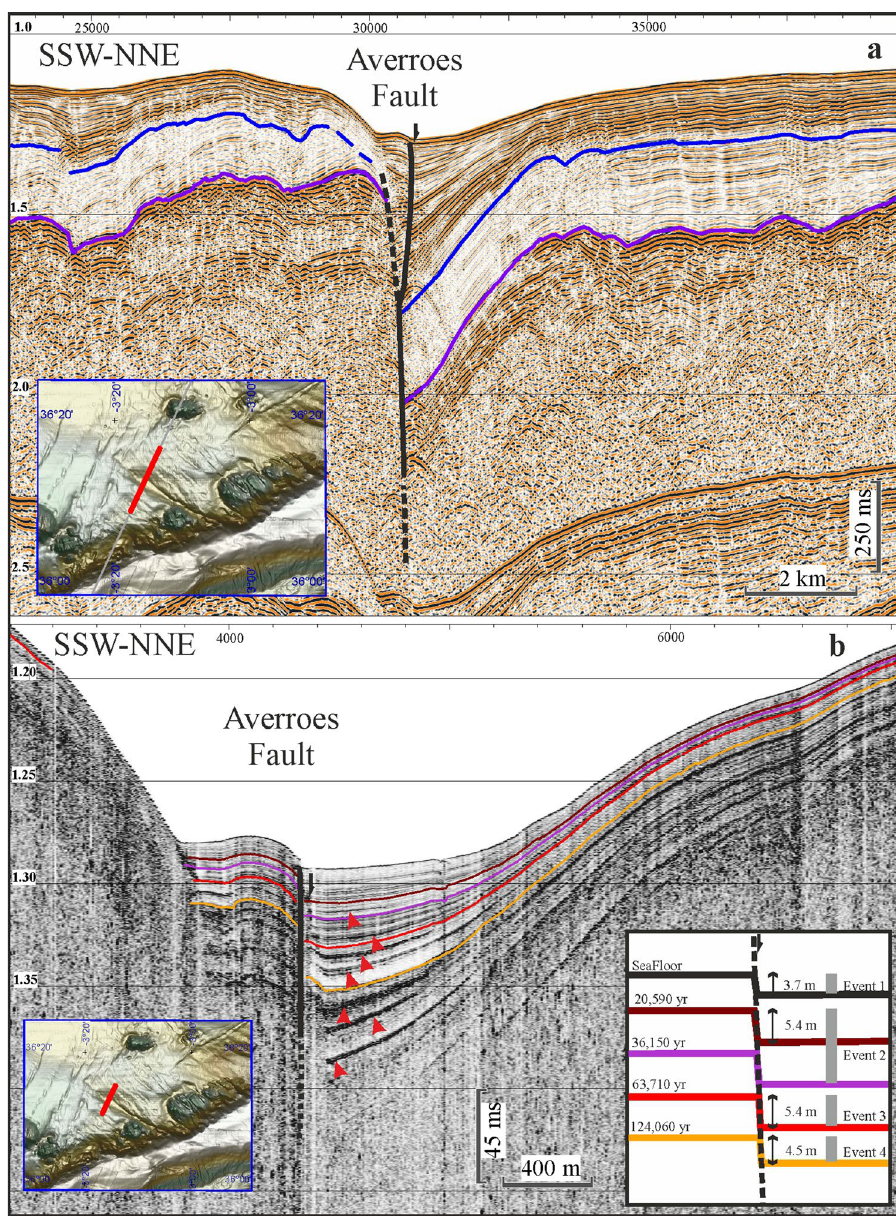
Figure 2. Seismic profiles illustrating the Averroes Fault. ( a ) Airgun seismic profile showing the deep structure. Legend: purple line corresponds with top of Miocene and blue line with base of Quaternary. Horizontal and vertical scale respectively in metres and seconds, two-way travel time (twtt). Vertical exaggeration × 8.7; ( b ) Parametric TOPAS profile (ultra-high-resolution) illustrating the upper reach (75 m) of the Averroes Fault. Inlet shows chronostratigraphic boundaries and fault events over the last 124,060 years. Red arrows indicate co-seismic wedges. Horizontal scale in metres and vertical scale in seconds (twtt). Vertical exaggeration × 12.4. (Figures generated using IHS Kingdom v. 2017, https:// ihsma rkit. com, and mounted with CorelDRAW v. X7, https:// www. corel.